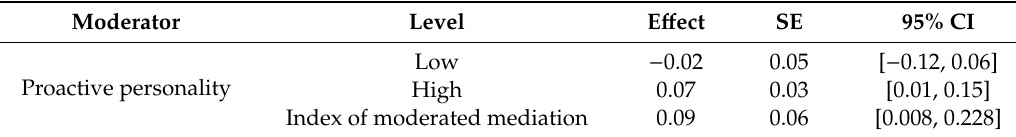
Table 5. Conditional indirect effects.